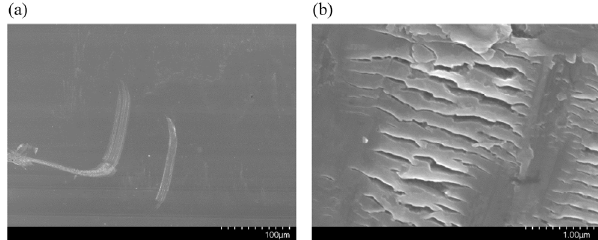
Fig. 8 Wear morphology of the silicon surface after friction with a PP ball with an inclined contact.